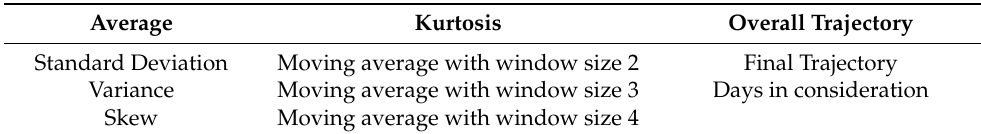
Table 3. Features Engineered in this Research.